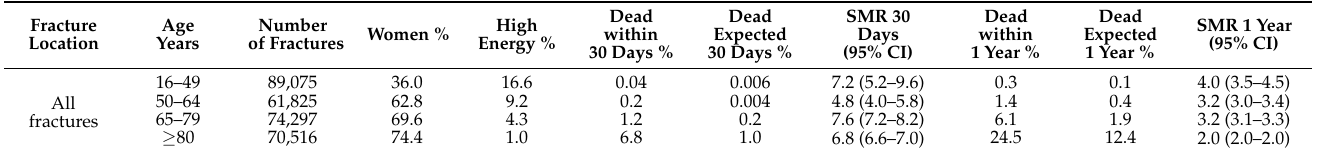
Table 1. Baseline data, proportion deceased within 30 days and 1 year after sustaining a fracture, and Standardized Mortality Ratio (SMR) with 95% CI, for different age